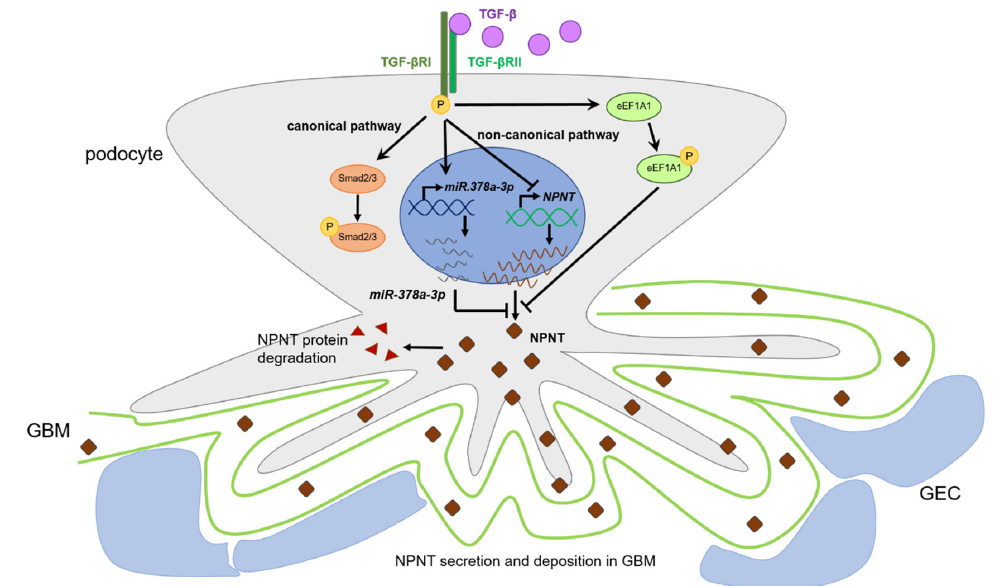
Figure 7. Proposed mechanism of podocyte NPNT regulation by TGF- β . We propose that podocyte NPNT expression is regulated primarily via the non-canonical TGF- β pathways. This regulation is mediated directly via inhibition of NPNT transcription and indirectly via miR-378a-3p. TGF- β RI- mediated phosphorylation of eukaryotic elongation factor 1A1 (eEF1A1) might further be involved in the regulation of protein translation [33]. Intracellular NPNT is either secreted and deposited into the glomerular basement membrane (GBM) or degraded. GEC = glomerular endothelial